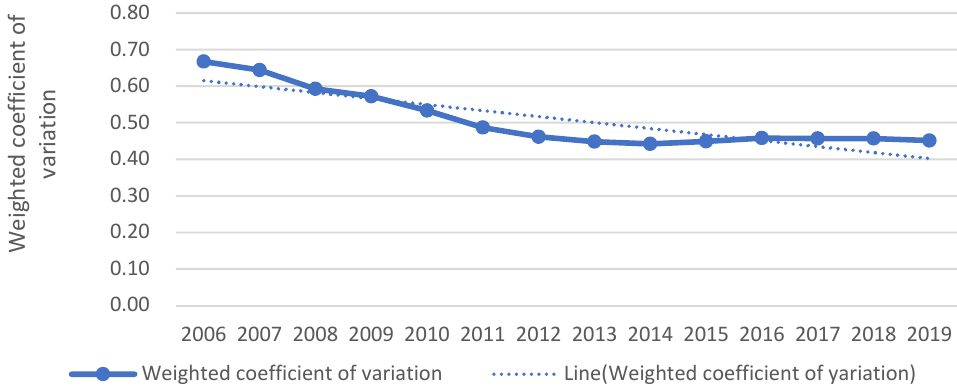
Figure 3. The comprehensive gap in China’s per-capita GDP from 2006 to 2019.